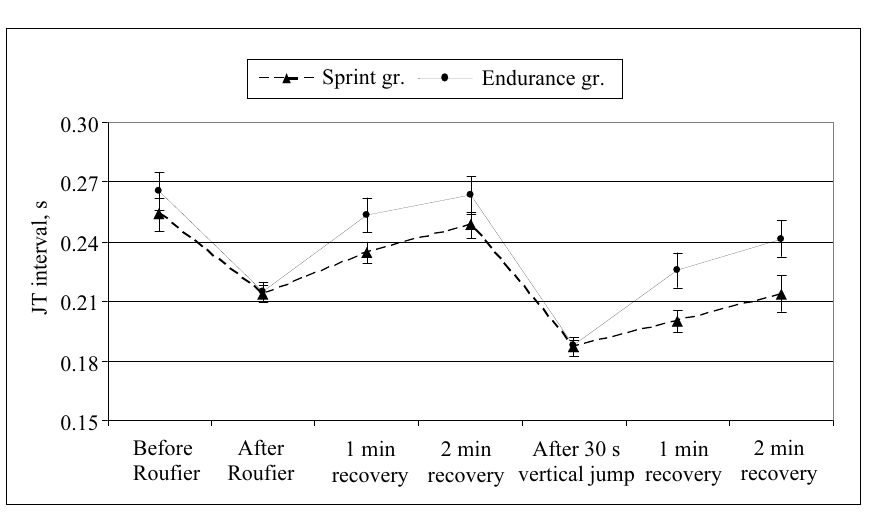
Figure 2. Dynamics of JT interval during dosed and maximal exercise test